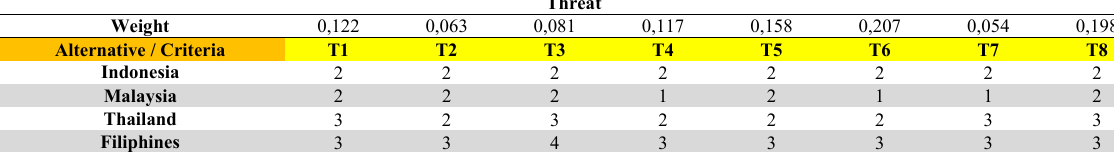
Value of Risk Analysis for Threat Aspects (T) Alternative